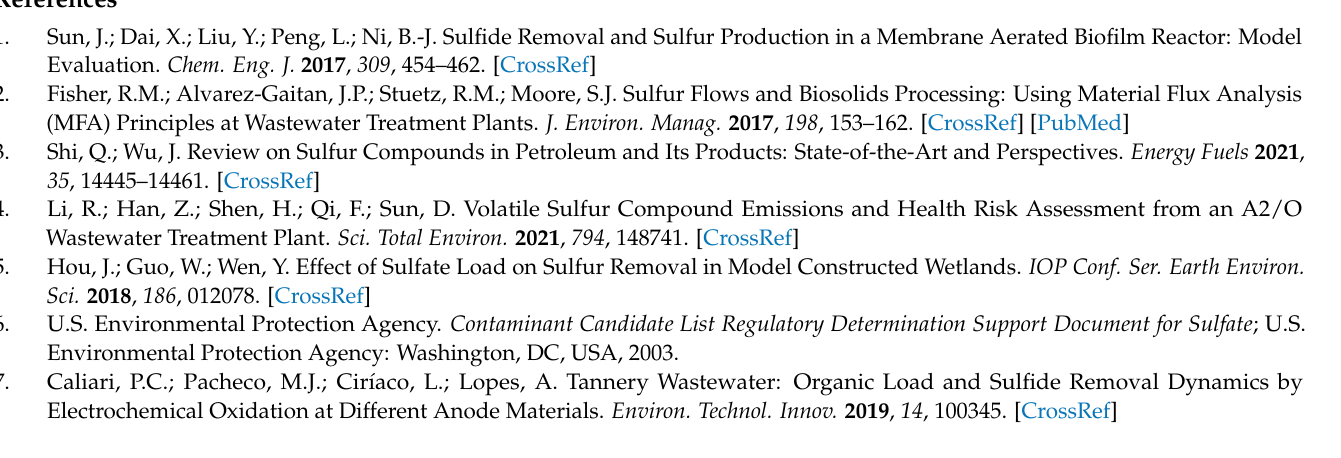
Table S2: Solution C composition for the acclimatization